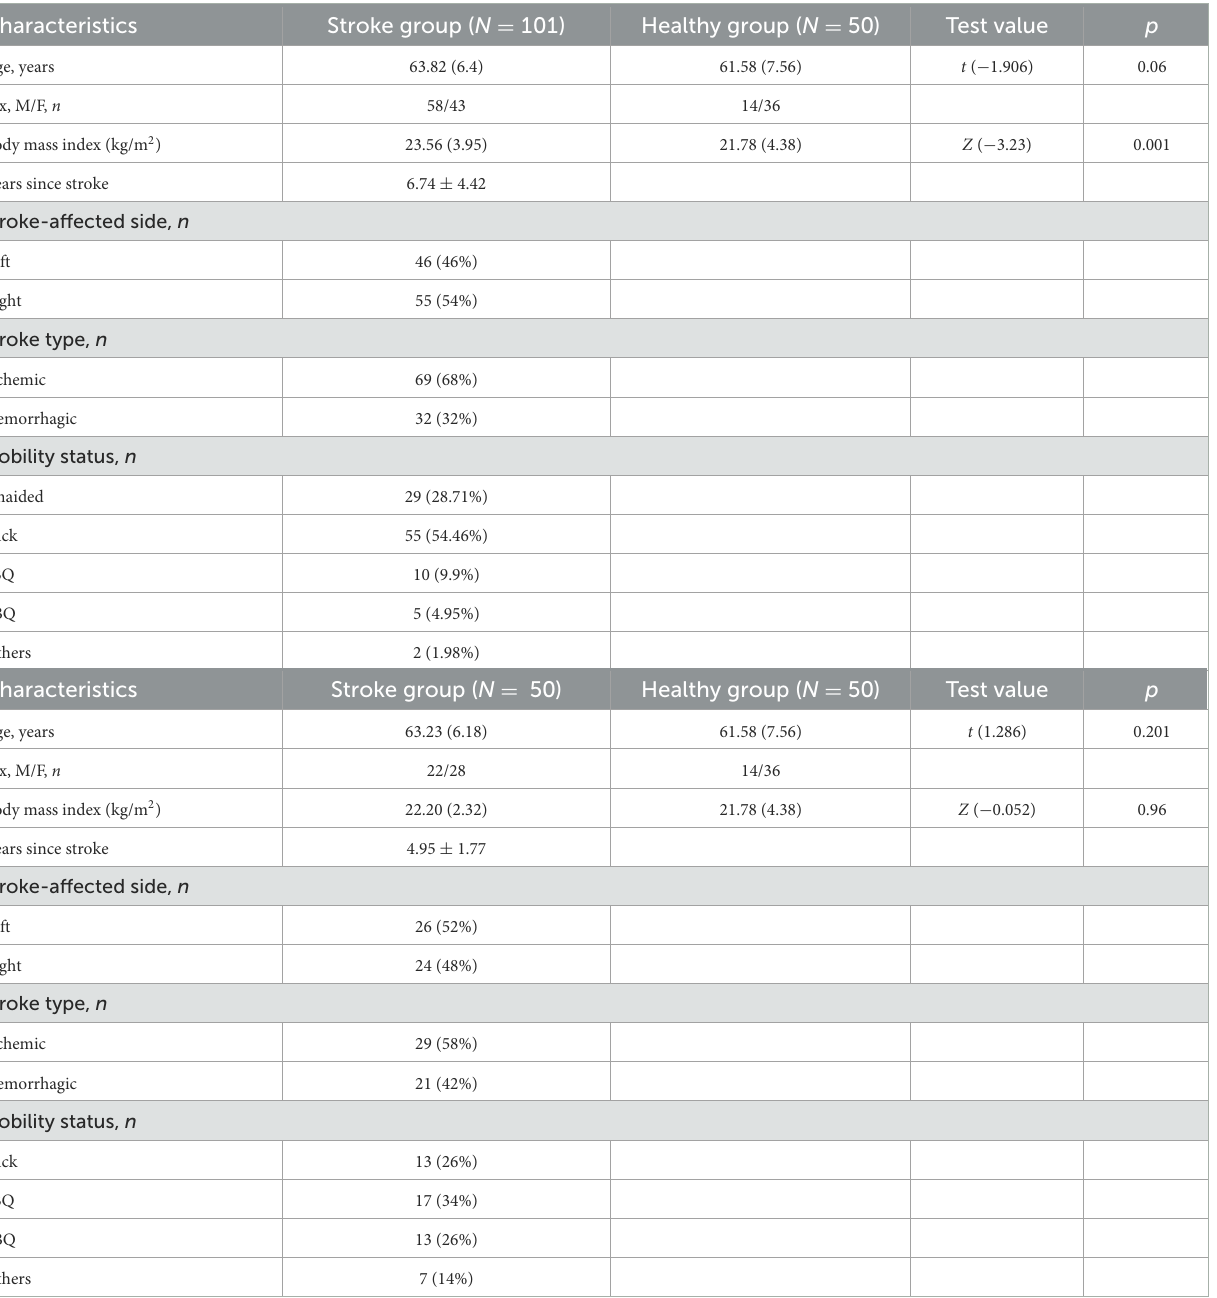
TABLE 1 Demographics of the people with stroke and the healthy older